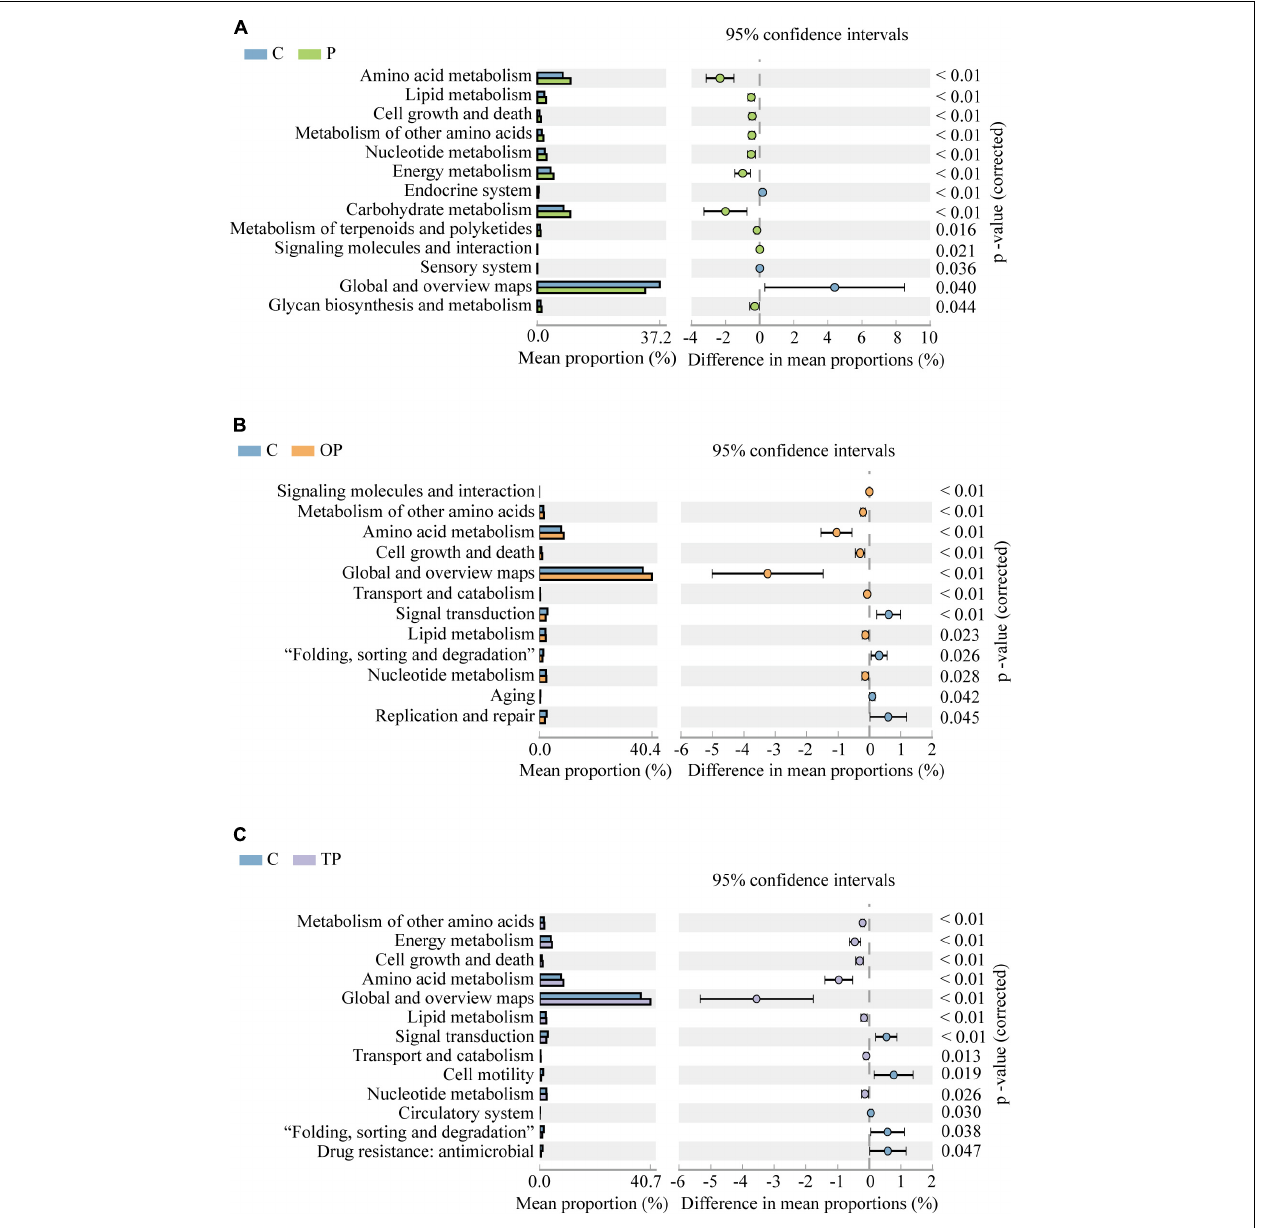
FIGURE 9 | Differences of intestinal microbial functions predicted at level 2 of Kyoto Encyclopedia for Genes and Genomes (KEGG) pathways using PICRUSt. Only data with significant differences ( P < 0.05) between treatments are shown. (A) C and P treatment, (B) C and OP treatment, (C) C and TP treatment. C (control): basal diet; P: basal diet supplementation with 0.5% PHB; OP: basal diet supplementation with 1% PHB; TP: basal diet supplementation with 3%